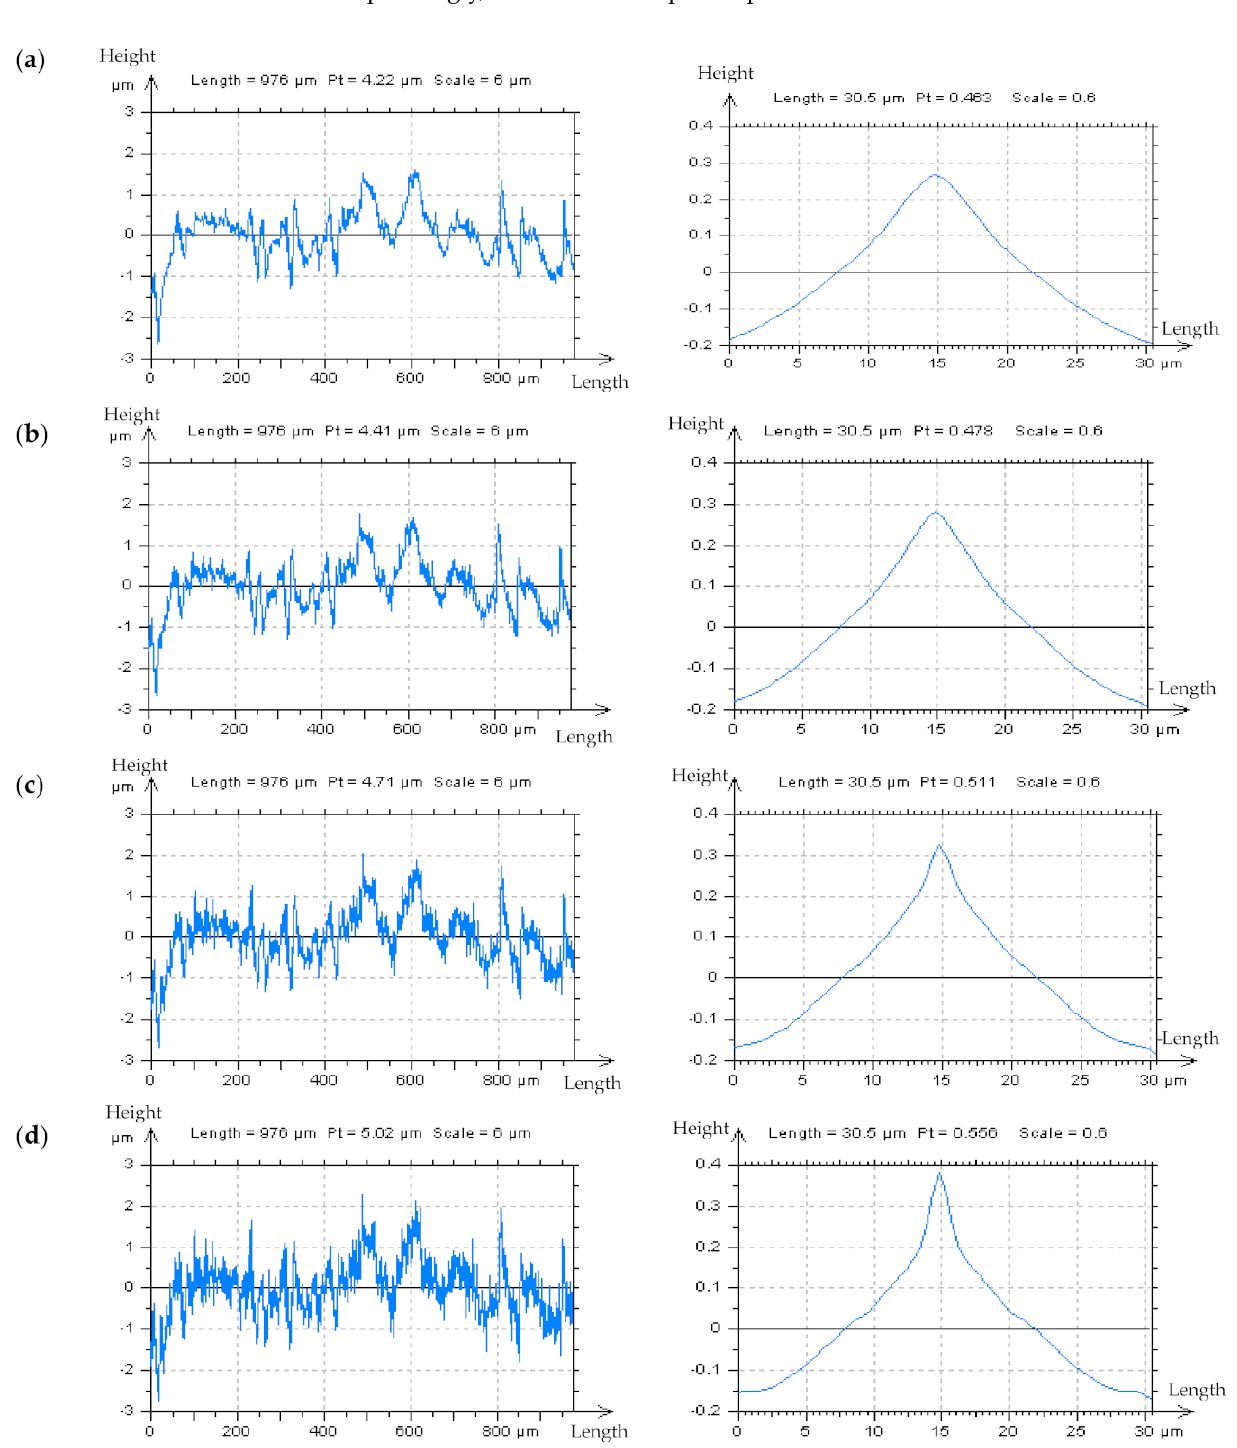
Figure 4. The profiles and their respective centre–parts of their ACFs, measured with stylus instrument of turned details, measured at the speed of ( a ) 0.5 mm/s and with added generated noise with Sq equal to 10% ( b ), 20%, ( c ) and 30% ( d ) of Sq of the analyzed